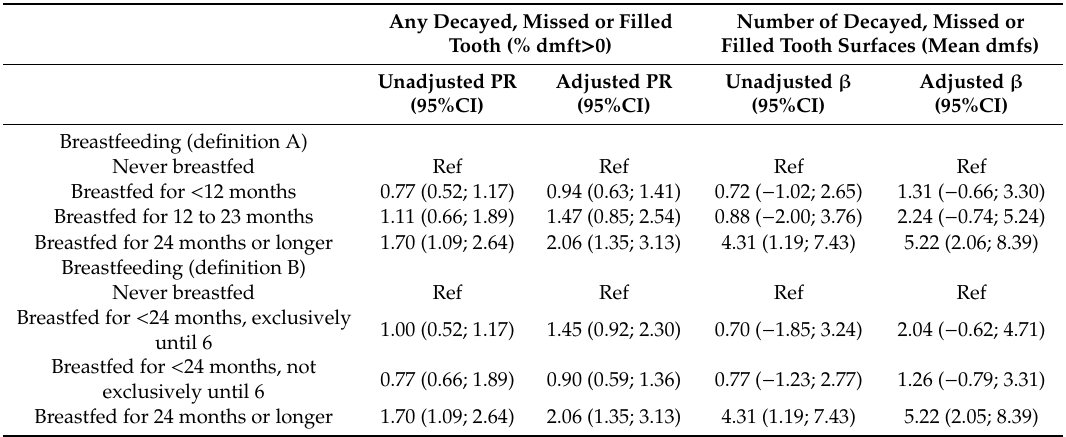
Table 2. Associations between breastfeeding patterns with dental caries prevalence and severity. Any Decayed, Missed or Filled Tooth (% dmft >